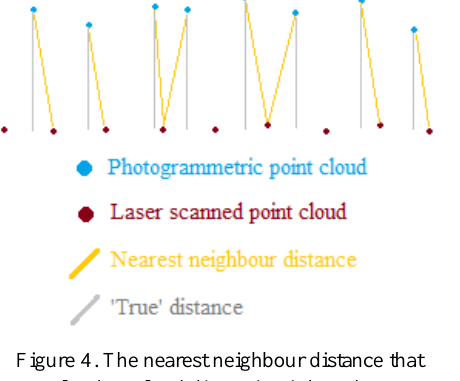
Figure 4. The nearest neighbour distance that cloud-to-cloud distancing is based on